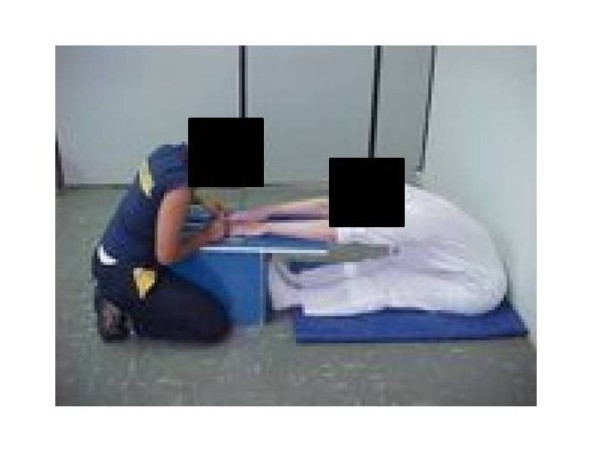
Bank of Wells test.